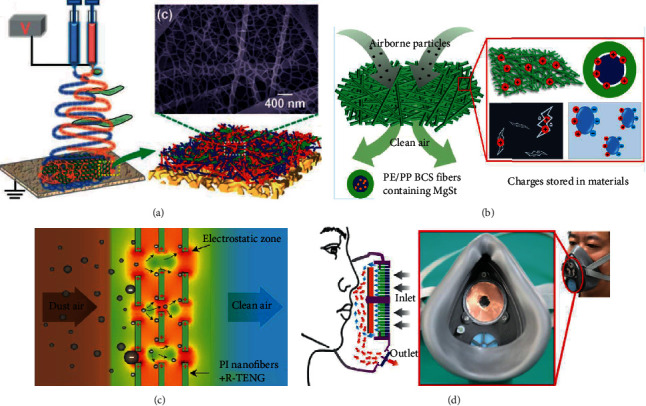
(a) Schematic showing the fabrication of nylon-6/PAN nanofibre/net membranes by electrospinning/netting technology. (b) Schematic showing an electret filter consists of PE/PP nanofibre as the matrix and magnesium stearate as the charge enhancer. (c) Schematic image of the filtration mechanism of the filter with R-TENG. (d) Structure and photo of a self-powered electrostatic adsorption face mask with R-TENG. Reprinted with permission from Ref. [126], copyright 2015, Macmillan Publishers Limited; Ref. [139], copyright 2015, The Royal Society of Chemistry; and Ref. [140–142], copyright 2017–2019, American Chemical Society.